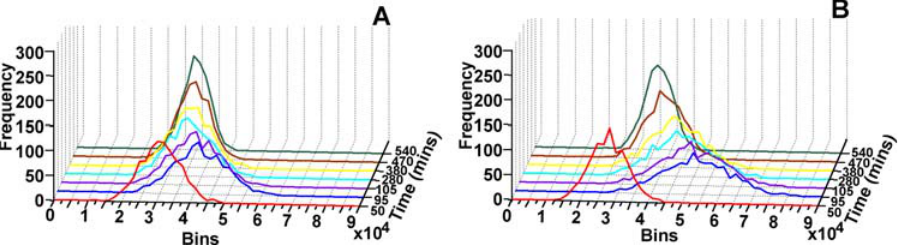
Figure 5. Theoretical frequency distributions of GFP in cell populations: (A) Basic, and (B) Delay circuits at different time intervals.